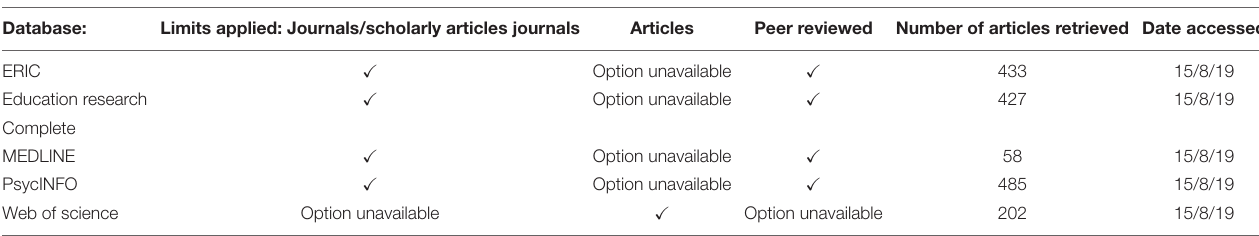
TABLE 3 | Overview of database searches and limits